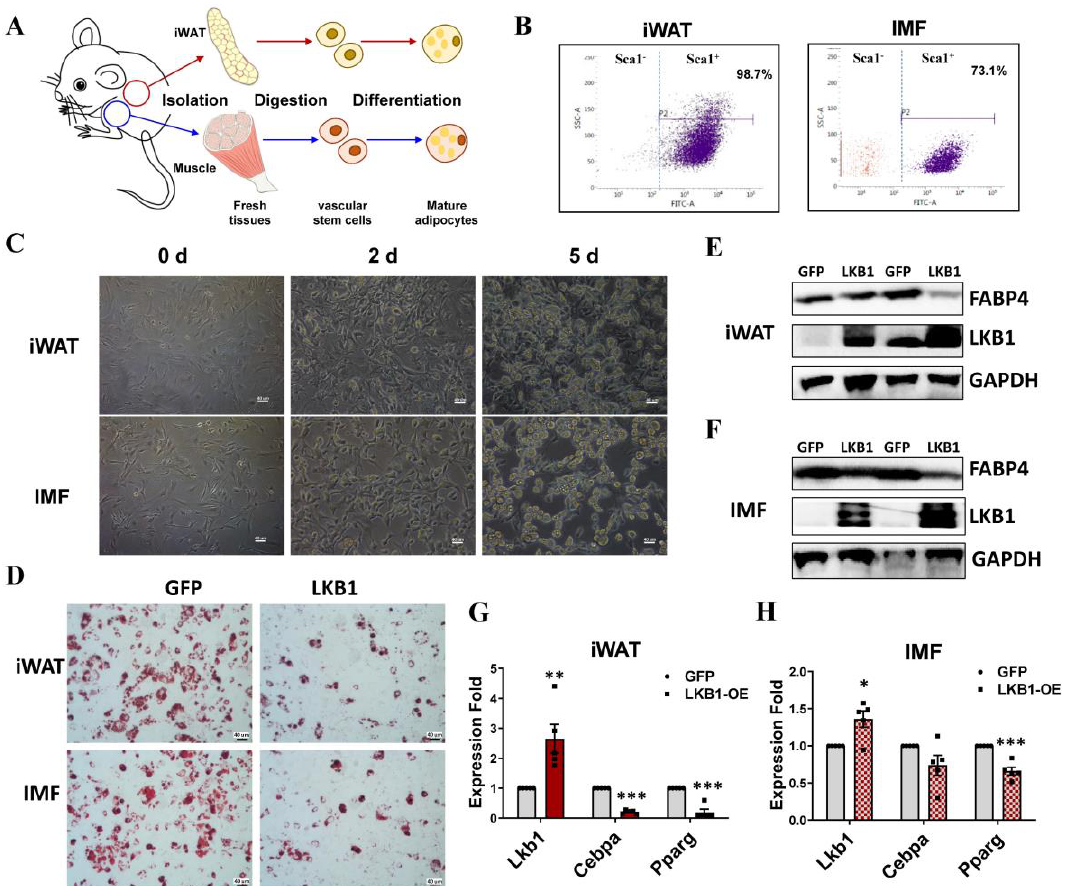
Figure 6. Comparison of mouse IMF and inguinal white adipose tissue (iWAT) adipocytes during adipogenic differentiation and upon LKB1 regulation. ( A ) Experimental design. IMF and iWAT preadipocytes were isolated from muscle and adipose tissue, respectively, from growing mice and used in subsequent experiments. ( B ) Flow cytometry-based quantitation of Sca1 + populations in iWAT and IMF adipocytes. ( C ) Optical microscope images of iWAT and IMF adipocytes during adipogenic differentiation. ( D ) Oil Red O-staining of iWAT and IMF adipocytes upon LKB1 overexpressing and control adenovirus infections. ( E , F ) Western blot results of the protein expression levels of FABP4, LKB1 and GAPDH in iWAT ( E ) and IMF ( F ) adipocytes upon LKB1-overexpressing and control adenovirus infections. ( G , H ) qPCR results of the mRNA levels of Lkb1 , Cebpa , and Pparg in iWAT ( G ) and IMF ( H ) adipocytes upon LKB1-overexpressing and control adenovirus infections. Data are presented as means ± SEM (n = 5). * p < 0.05, ** p < 0.01, *** p < 0.001.